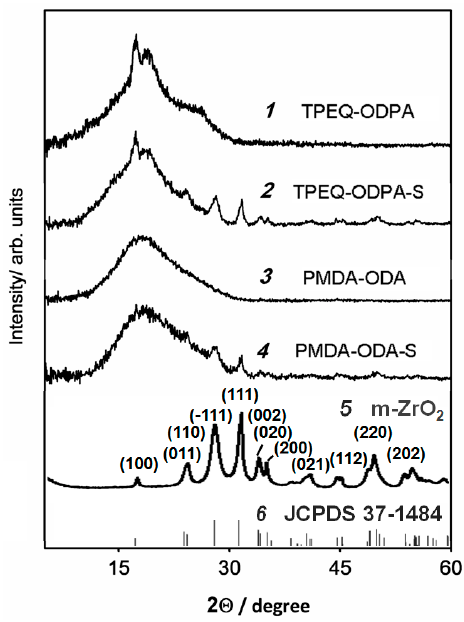
Figure 6. Wide angle X-ray diffraction (WAXD) patterns for the ( 1 ) TPEQ-ODPA; ( 2 ) TPEQ-ODPA-S; ( 3 ) PMDA-ODA; ( 4 ) PMDA-ODA-S; ( 5 ) ZrO 2 ; and ( 6 ) reference pattern for monoclinic zirconia.